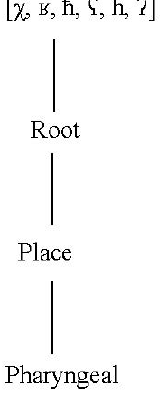
Figure 13. Feature geometry of Arabic gutturals.